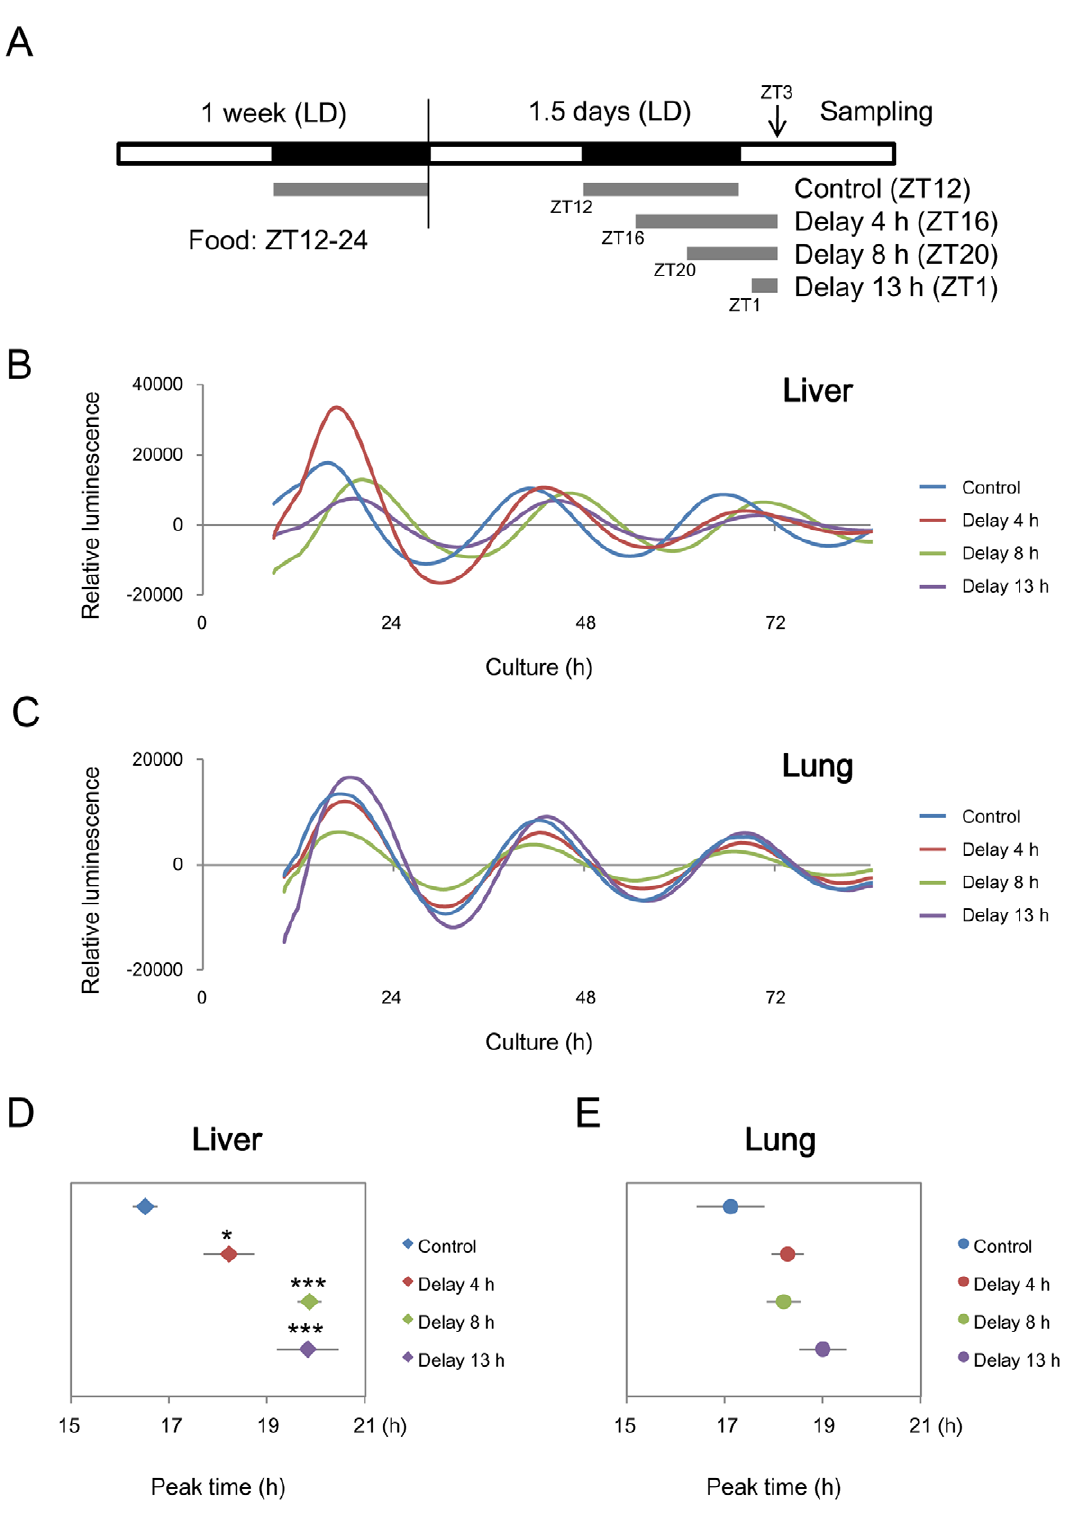
Figure 1. Single feeding delays phase of liver, but not lung clock. After a night-time restricted feeding schedule (ZT12-24) for one week, mice were divided into 4 groups and then delayed feeding was applied as follows. Mice in the 4, 8 and 13 h delayed groups were fed from ZT16, 20, and the next ZT1, respectively. Control mice were fed from ZT12 to ZT24. White and black boxes indicate day and night respectively; gray lines show feeding times (A). Representative circadian profiles of reporter luminescence in explants of livers (B) and lungs (C) isolated from mPer2::Luc knockin mice. Peak times of circadian oscillation between 12 and 36 h in culture are shown for liver (D) and lung (E). Values are shown as means 6 SEM (n=7 for ZT12 and ZT16, and n=5 for ZT20 and ZT1; * p , 0.05, *** p , 0.001; vs. control; Dunnett’s test).